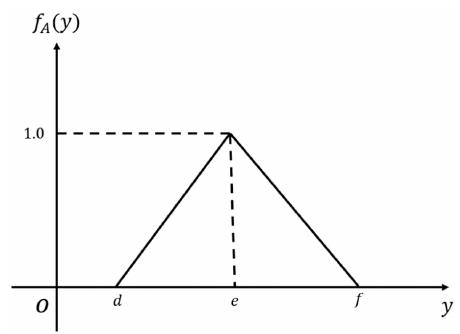
Figure 2. T he membership function of the Triangular Fuzzy Number. Figure 2. The membership function of the Triangular Fuzzy